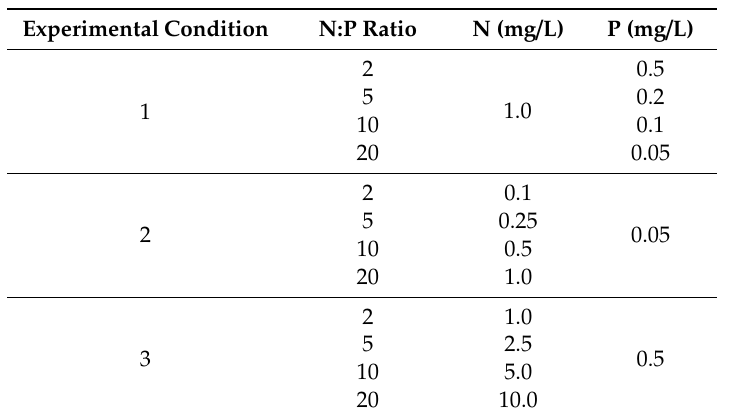
Table1. Experimentaldesignofthestudy. TwelvetreatmentsofNorPconcentrationswereadministered under each salinity